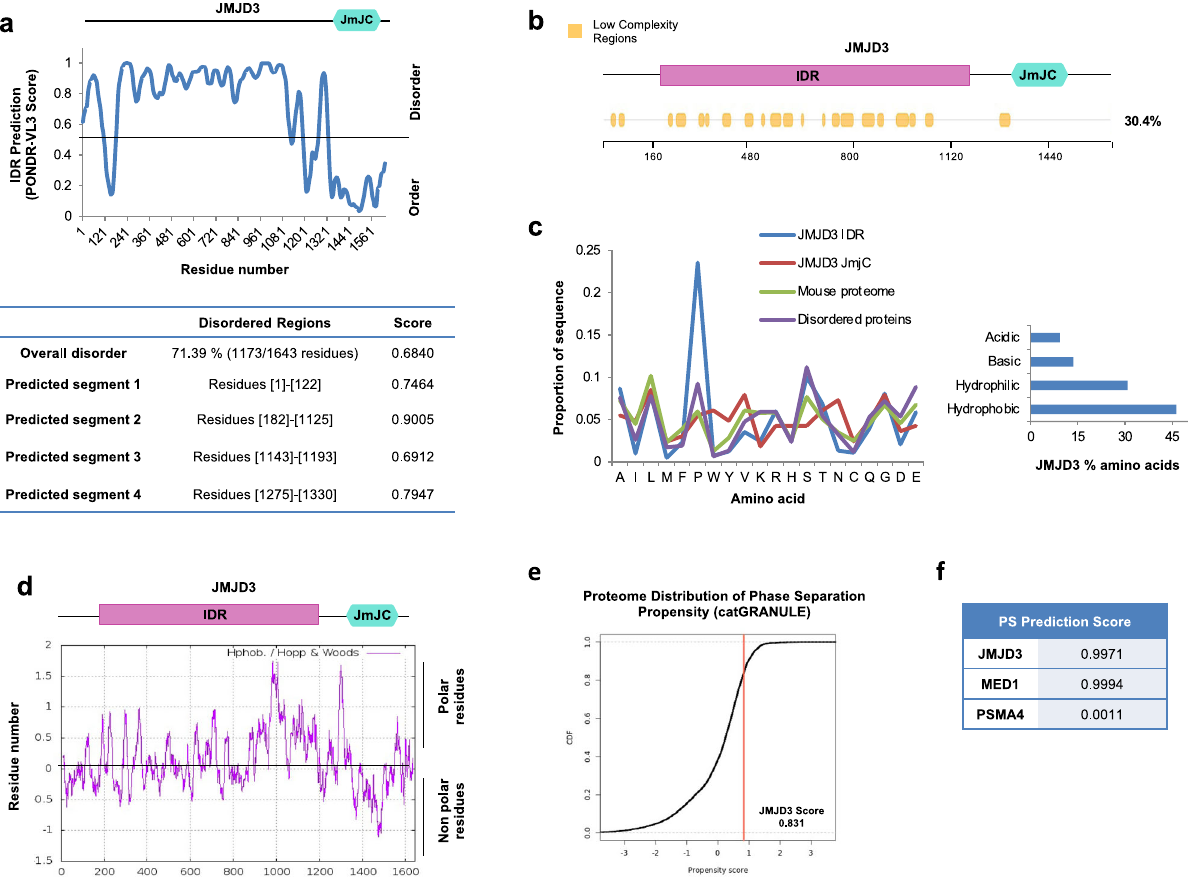
Fig. 4 JMJD3 is a highly disordered protein. a Disorder prediction of human JMJD3 using PONDR-VL3 algorithm. In the bottom panel, the disorder score and the lengths of the predicted disordered regions are indicated (length of disordered segments >50 amino acids). A schematic representation of JMJD3 described domains is shown on top of the graphic. b Analysis of the presence of low-complexity domains in JMJD3 using the SEG algorithm. The percentage of low complexity regions is indicated on the right side. Low complexity regions are depicted in yellow. A schematic representation of JMJD3 described domains is shown on top of the panel. c Amino acid composition of JMJD3 IDR, JMJD3 catalytic domain, mouse proteome and disordered proteins de fi ned by the presence of a 50 residues fragment whose IUPRED median score is at least 0.55 and that is not found in Pfam (so that functional domains are avoided). The percentages of acid, basic, hydrophobic, and hydrophilic amino acids of JMJD3 are shown on the right panel. d JMJD3 hydrophobicity pro fi le was determined using the ExPASy website with the Hopp and Woods scale and a sliding window of 21. e , f The potential of JMJD3 to phase separate was determined using catGRANULE (on the left) ( e ) and PSPredictor (on the right) ( f )